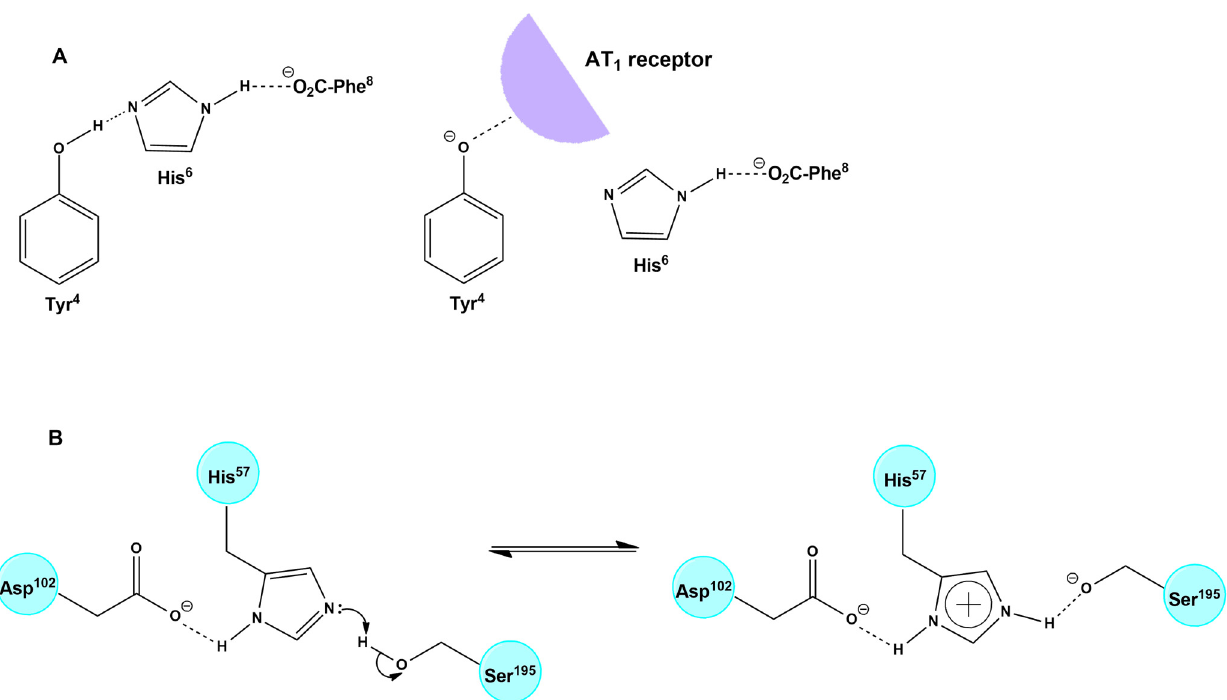
Figure 7. Hypothetical mechanism of action for DIZE may be similar to AngII and EXP3174. ( A ) Interaction of ANGII with the receptor through CRS ( B ) Mechanism of action of Serine Proteases: Catalytic